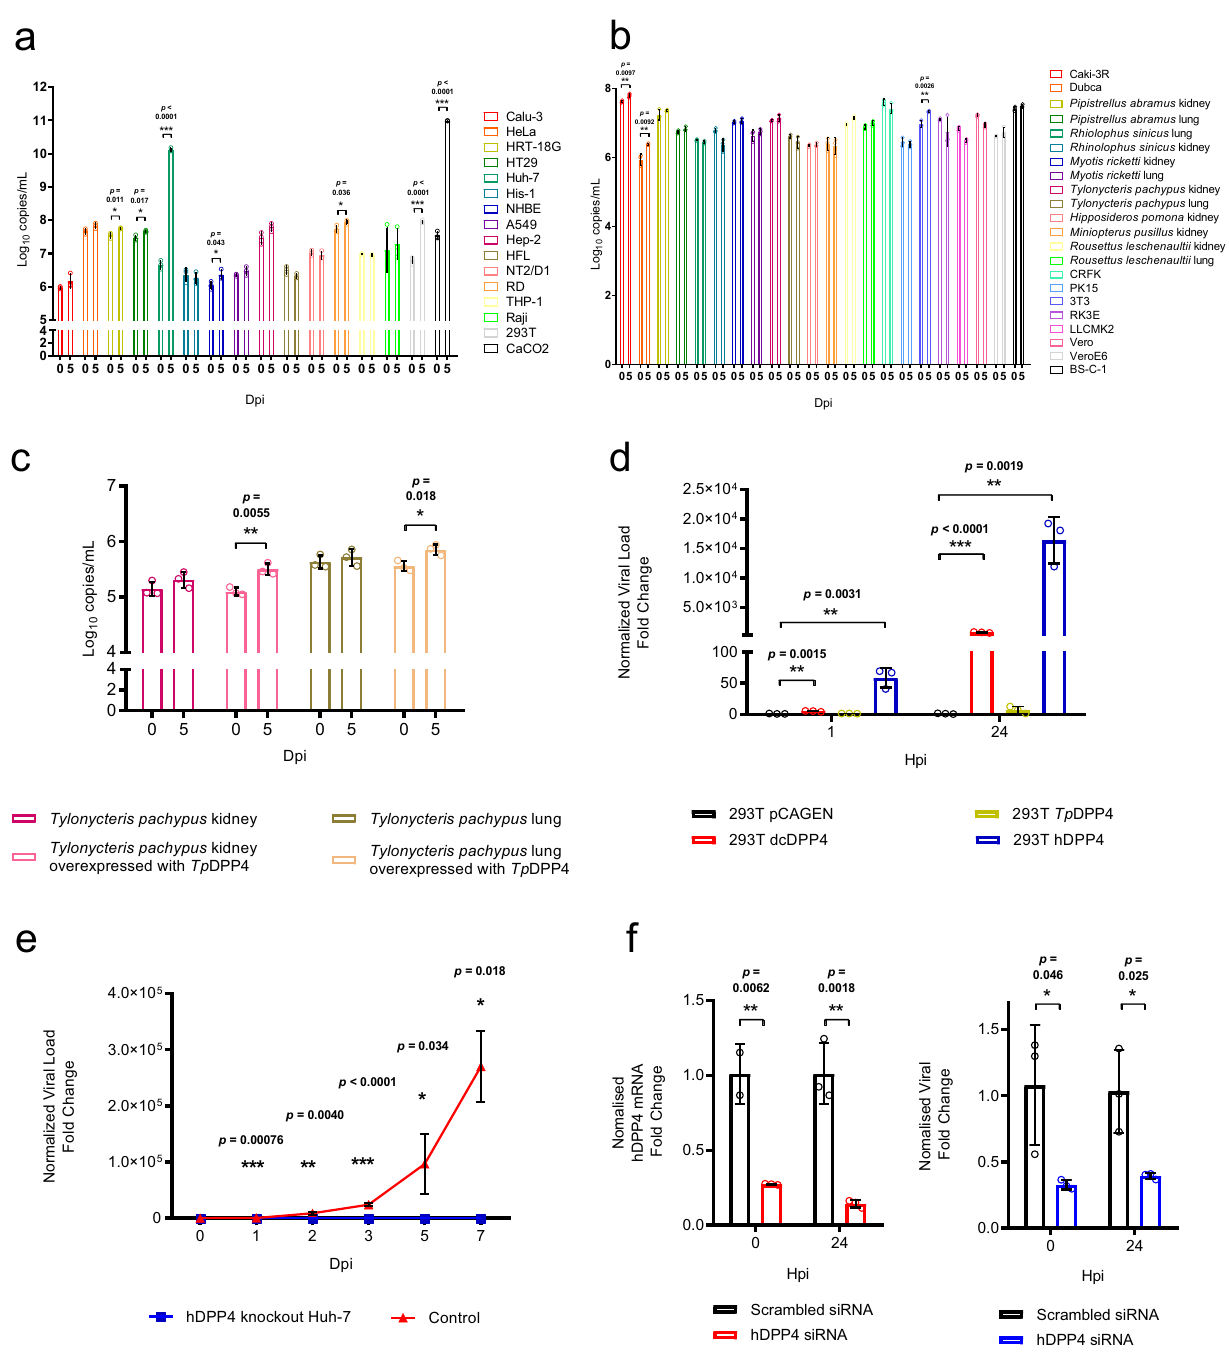
Fig. 2 Cellular tropism and receptor usage of Ty-BatCoV HKU4 SM3A. Ty -BatCoV HKU4 SM3A of 1 MOI was inoculated to a 16 human cell lines; b 12 bat and 10 other mammalian cell lines; c primary Tylonycteris pachypus kidney and lung cells with overexpressed Tp DPP4; d different host-DPP4-expressing 293 T cells; e hDPP4 CRISPR-knockout Huh7 cells; and f siRNA hDPP4-knockdown Huh7 cells. Culture supernatants ( a – c , e , f ) and cell lysates ( d ) were harvested from respective timepoints and viral titers were determined by RT-qPCR and normalized to β -actin gene. f siRNA ef fi ciency was determined by measuring hDPP4 mRNA expression level in knockdown Huh7 cell lysate at 0 and 24 hpi and compared with mock-treated samples. Data are presented as mean values ± SD, n = 3 independent biological replicates for each cell line at each time point. Dots in each graph represent individual samples. The p- values calculated by multiple two-tailed unpaired t -test without correction for multiple comparisons (<0.05) are indicated in each graph. Statistical signi fi cances are indicated by the asterisks (* P < 0.05; ** P < 0.01; *** P < 0.0001). Table 4). All mice survived till 28 days post-infection (dpi) respectively, with viral clearance on 28 dpi (Fig. 4b). RT-qPCR (Fig. 4a). Ty -BatCoV HKU4 was detected in the lungs, spleens showed that hDPP4 was stably expressed in different tissues and/or brains of infected mice. Reverse transcription quantitative (Supplementary Fig. 3). Histology of lung tissues showed mod- PCR (RT-qPCR) showed the highest viral loads in lung (2.84 erate to marked degree of lymphocytic in fi ltration within the log 10 copies/mg) and brain (2.99 log 10 copies/mg) on 4 and 14 dpi alveolar septa and macrophages in the alveoli, compatible with NATURE COMMUNICATIONS| (2021) 12:216